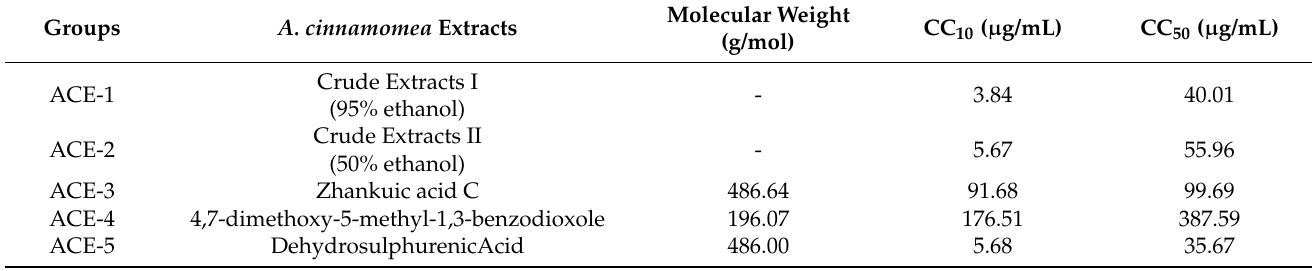
Table 1. The inhibition effects of prepared two ethanolic extracts and isolated three compounds from A. cinnamomea on Meg-01 cells.